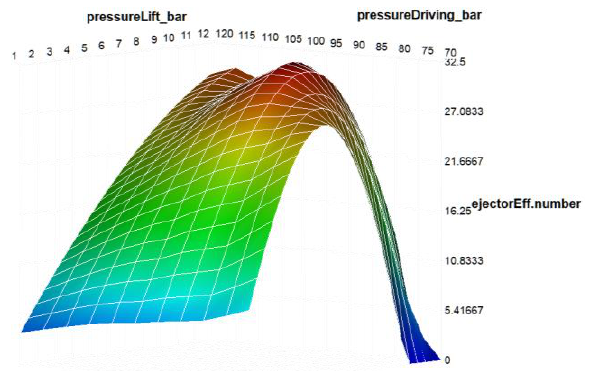
Figure 5. Ejector performance map for the utilized high-pressure lift ejector model in this study, illustrating the impact of pressure lift (from 1 to 12 bar) and driving pressure (from 70 to 120 bar) on the resulting ejector efficiency (from 0 to 32.5%).